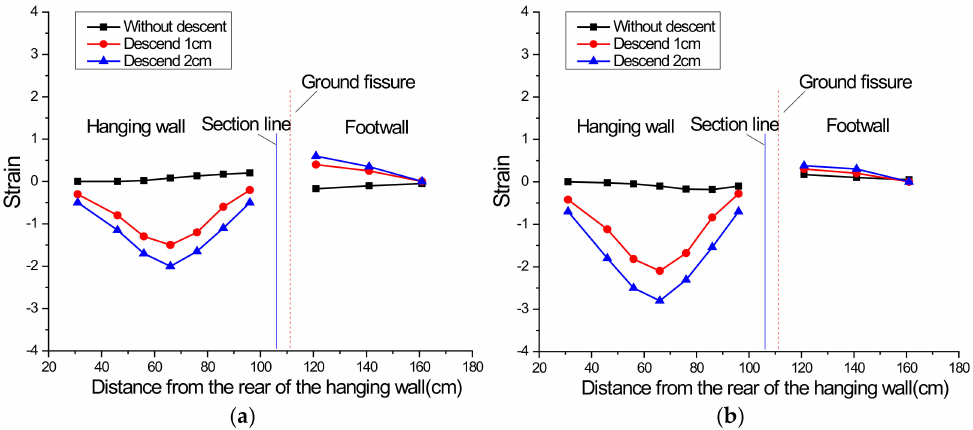
Figure 23. Distribution of the maximum longitudinal additional strain at the tunnel crown: ( a ) vibra- tion exciter at 60 cm; ( b ) vibration exciter at 100